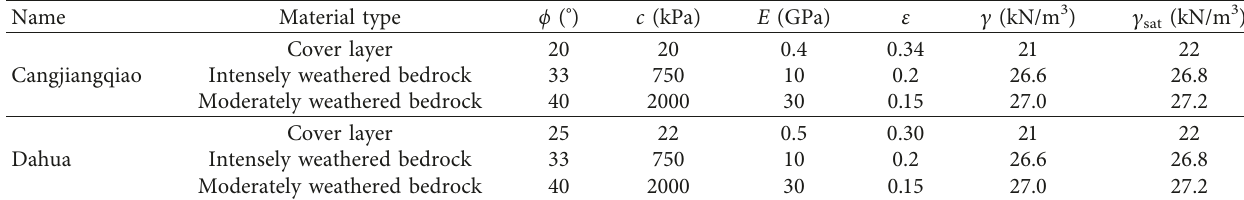
Table 2: Physicomechanical parameters for landslides in Dahuaqiao reservoir. Name